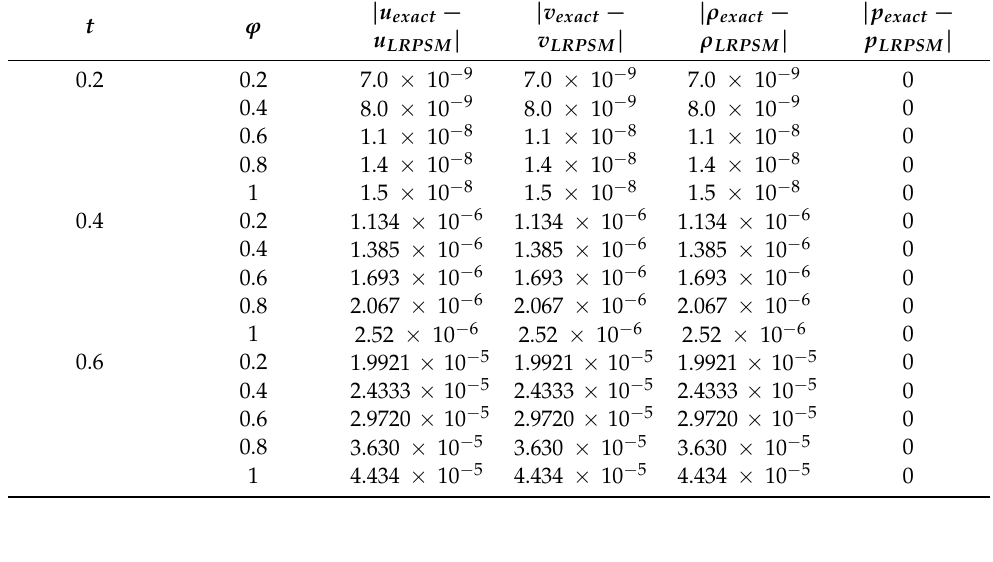
Table 1. Error analysis for the LRPSM solution for the proposed problem with various values of ϕ and t when ξ = 1, σ = 1.